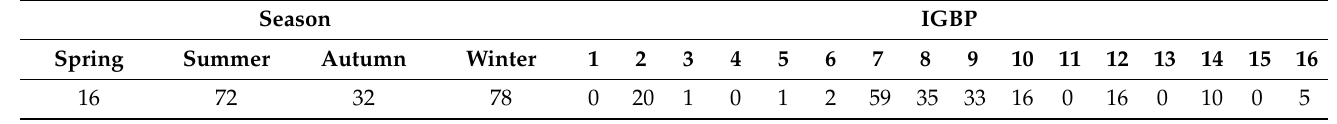
Figure 2. The spatial distribution for the 198 sets of concurrent POLDER, MODIS, and AHI pixels. Table 1. Seasons and land cover types of the selected pixels.